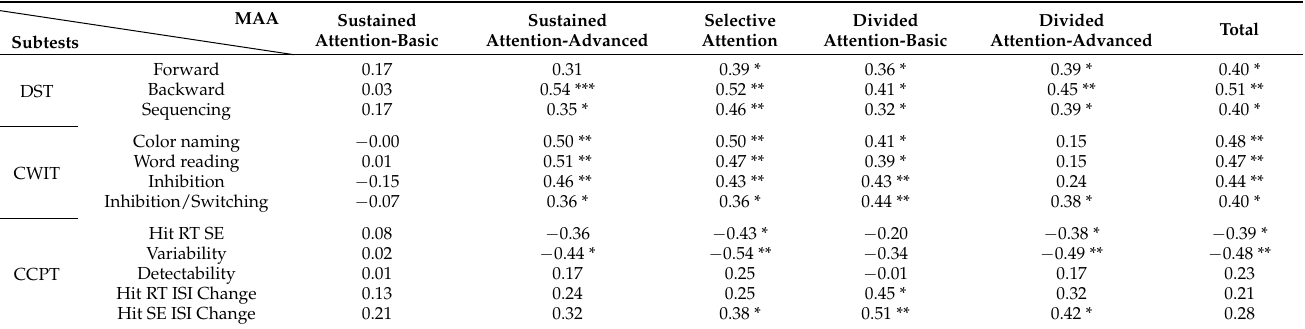
Table 4. Correlations between the MAA and neurocognitive batteries.